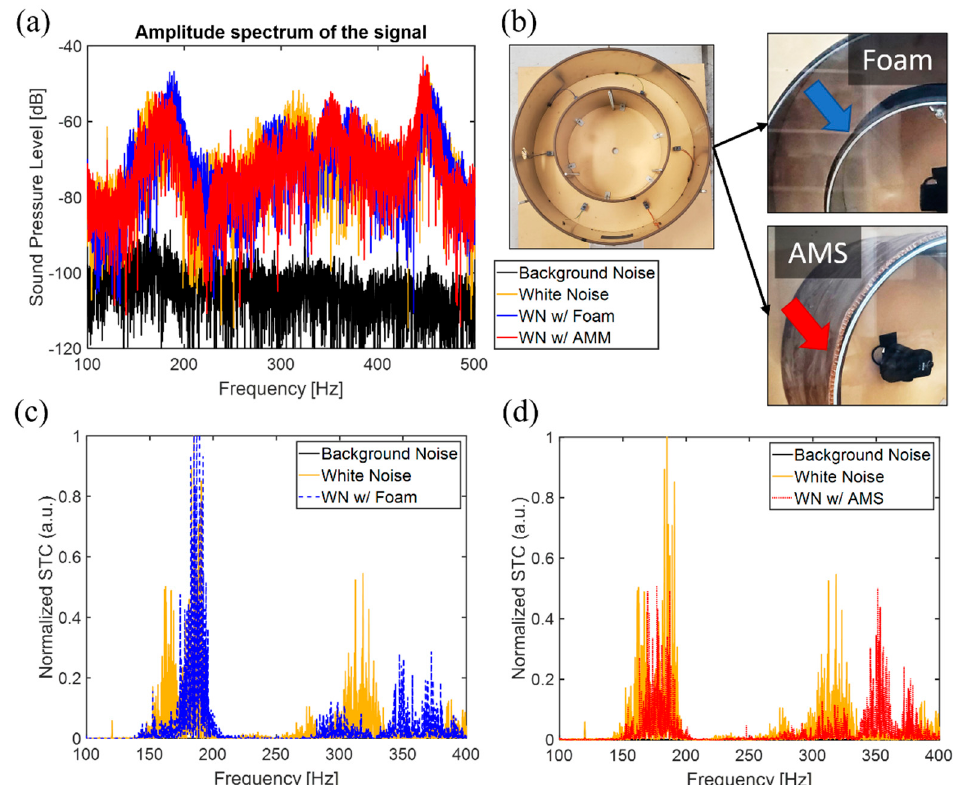
Figure 5. Sound pressure level ( a ) and normalized sound transmission coefficients ( c , d ) in the tire cavity model measured in the inner cavity. The background noise, black solid dashed lines, is the reference. The yellow lines represent the white noise (WN) when the speaker is turned on. The blue and red lines represent the attached foam and AMS, respectively. The pictures ( b ) display the cavity models with foam or AMS utilized in the experiment.